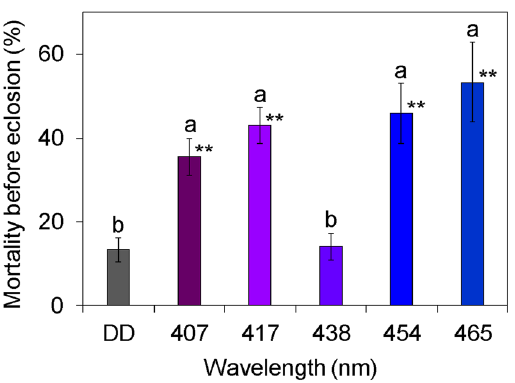
Figure 2. Mortality of beetles that were irradiated with blue light at ca. 15 × 10 18 photons·m − 2 ·s − 1 during the pupal stage and died before eclosion. Data are means ± standard error (SE). Asterisks at the upper right of the bars indicate significant differences between treatments with irradiation and dark conditions (Steel test: * P < 0.05, ** P < 0.01). Different lowercase letters ( a , b ) above the bars indicate significant differences (Steel– Dwass test, P < 0.05). DD indicates dark conditions. Nine replications (15 pupae/replicate) were